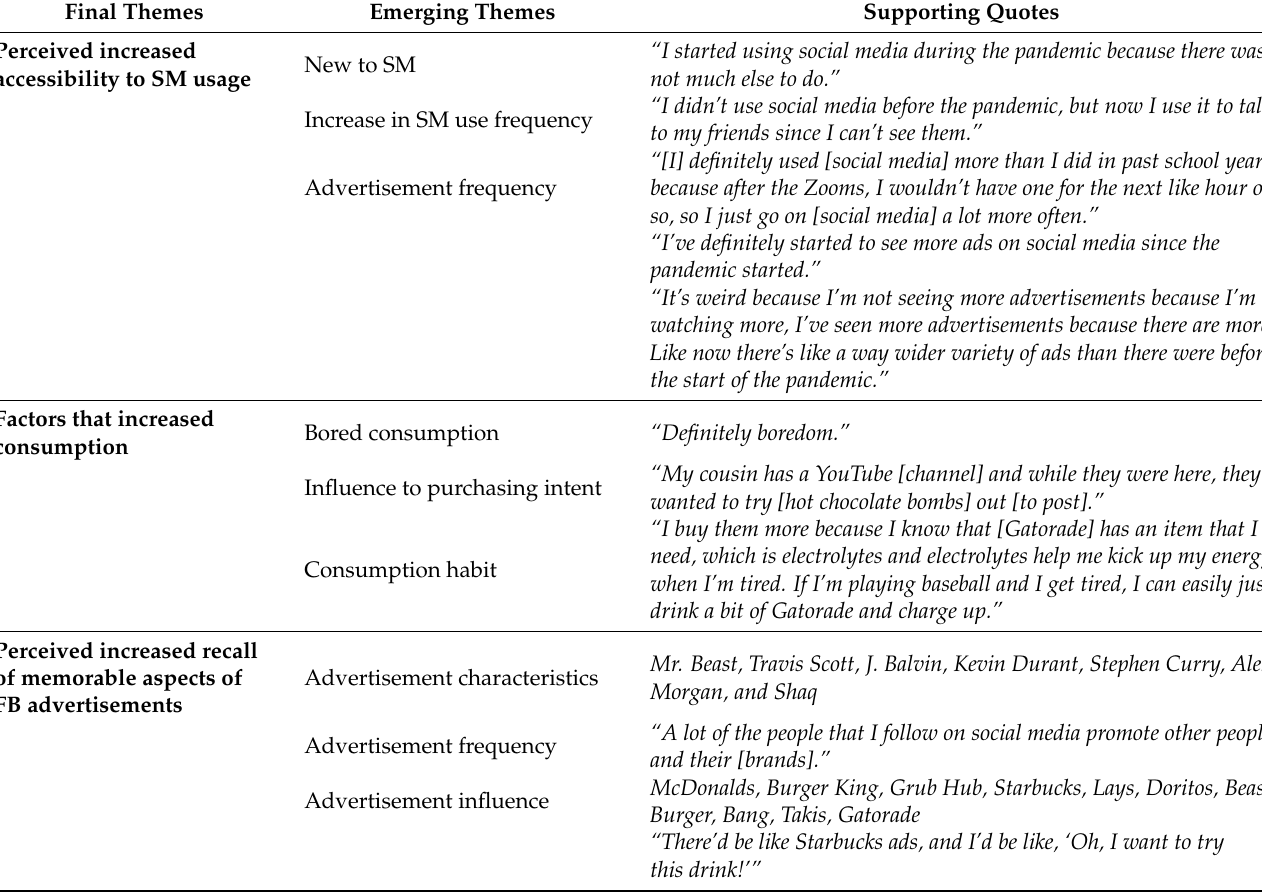
Table 5. Adolescent Qualitative Themes (n = 7).